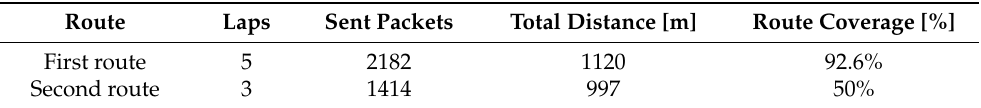
Table 3. Experiment routes